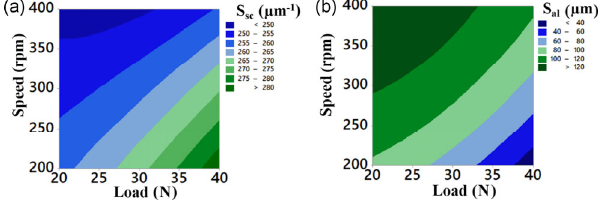
Fig. 22 Response surface plots of (a) mean summit curvature ( S sc ), S = 0.076, R -sq = 92.31%, α = 0.05, R -sq (adj.) = 83.49%, (b) autocorrelation length ( S al ), S = 9.6, R -sq = 96.86%, α = 0.05, R -sq (adj.) = 91.63%.